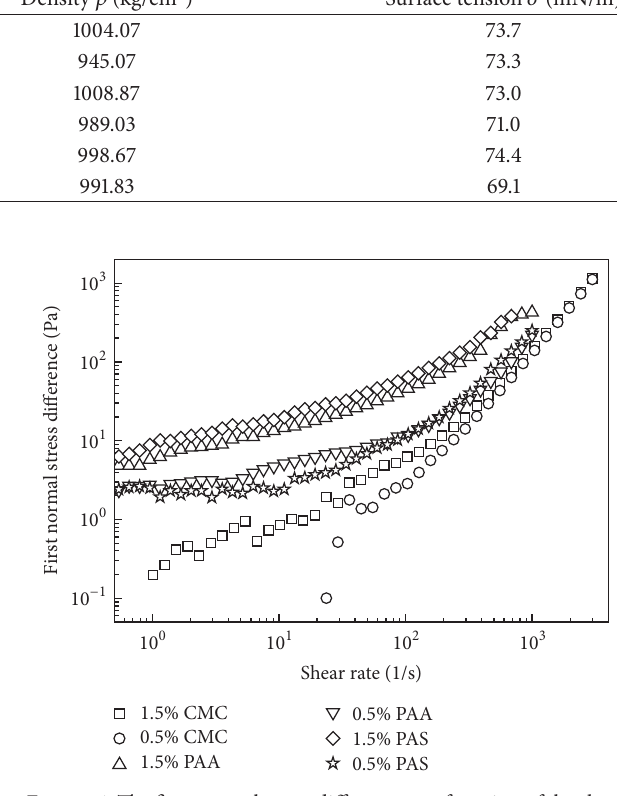
Figure 4: The first normal stress difference as a function of the shear rate for the studied